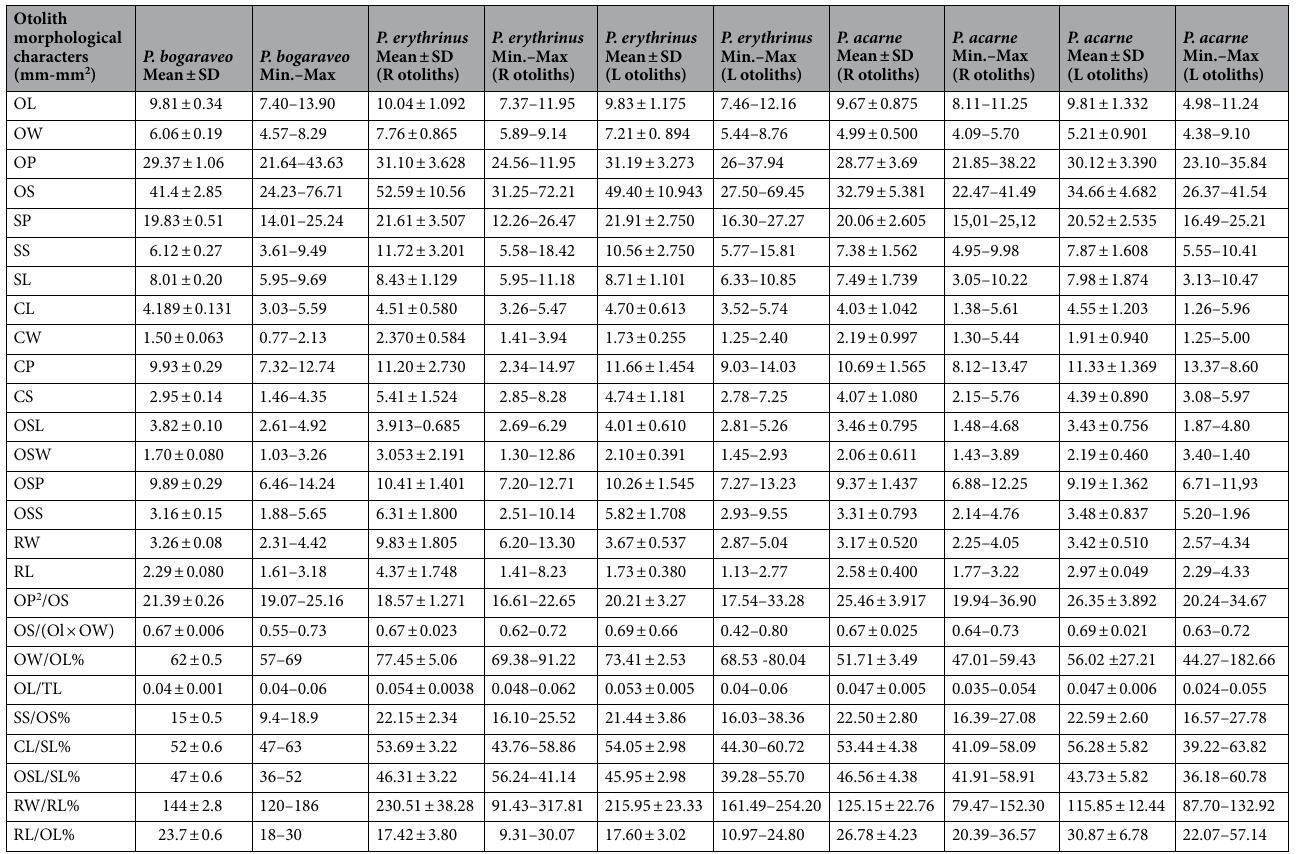
Table 2. Morphometric mean values with standard deviation (SD) and range of P. acarne , P. bogaraveo, and P. erythrinus adult group individuals: OL (otolith length), OW (otolith width), OP (otolith perimeter), OS (otolith surface), SP (sulcus perimeter), SS (sulcus surface), SL (sulcus length), SW (sulcus width), CL (cauda length), CW (cauda width), OSL (ostium length), OSW (ostium width), RW (rostrum width), RL (rostrum length), CI (circularity), RE (rectangularity), aspect ratio (OW/OL%), the ratio of otolith length to total fish length (OL/TL), percentage of otolith surface occupied by the sulcus (SS/OS%), percentage of the sulcus length occupied by the cauda length (CL/SL%), percentage of the sulcus length occupied by the ostium length (OSL/ SL%), rostrum aspect ratio (RW/RL%) and percentage of the rostrum length occupied by the otolith length (RL/OL%). (R = right, L =